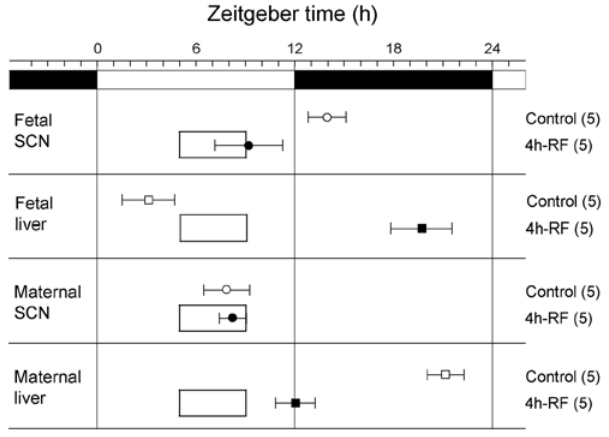
Figure 4. Effects of 4-hour restricted feeding on tissue luciferase rhythmicity. The average times ( 6 s.d., shown by error bars) of peaks from the different tissues are plotted against the LD cycle shown at the top of each panel. The timing and duration of food availability at ZT5-9 is indicated by open boxes in each section. The sample size is shown in parentheses. The phases of fetal SCN, fetal liver and maternal liver rhythmicity were significantly different from control values in all groups of RF rats (one-way ANOVA, p , 0.01); the phase of maternal SCN rhythmicity was not significantly different between control and 4h-RF groups.